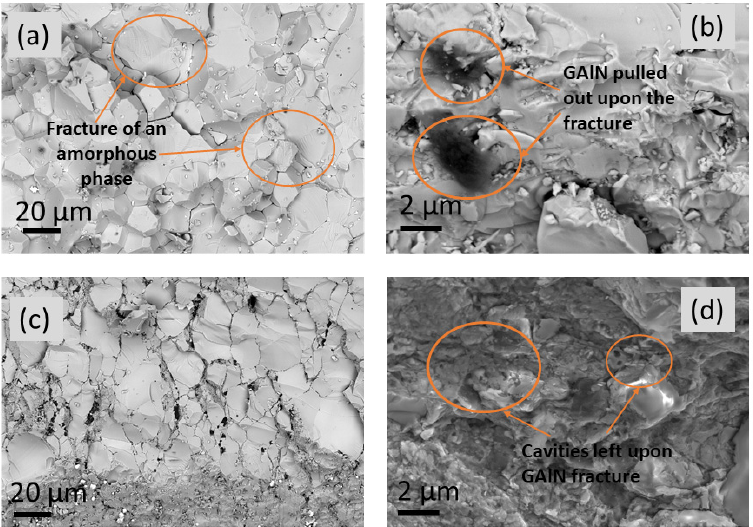
Figure 16. SEM photos of fracture surfaces, obtained for ( a ) 0 GAlN ceramics; ( b ) 1 GAlN composite; ( c ) 3 GAlN composite and ( d ) 5 GAlN composite. ( c ) 3 GAlN composite and ( d ) 5 GAlN